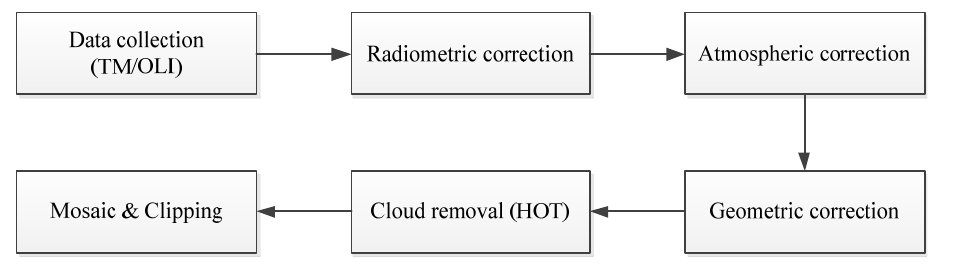
/ Operational Land Imager (OLI)